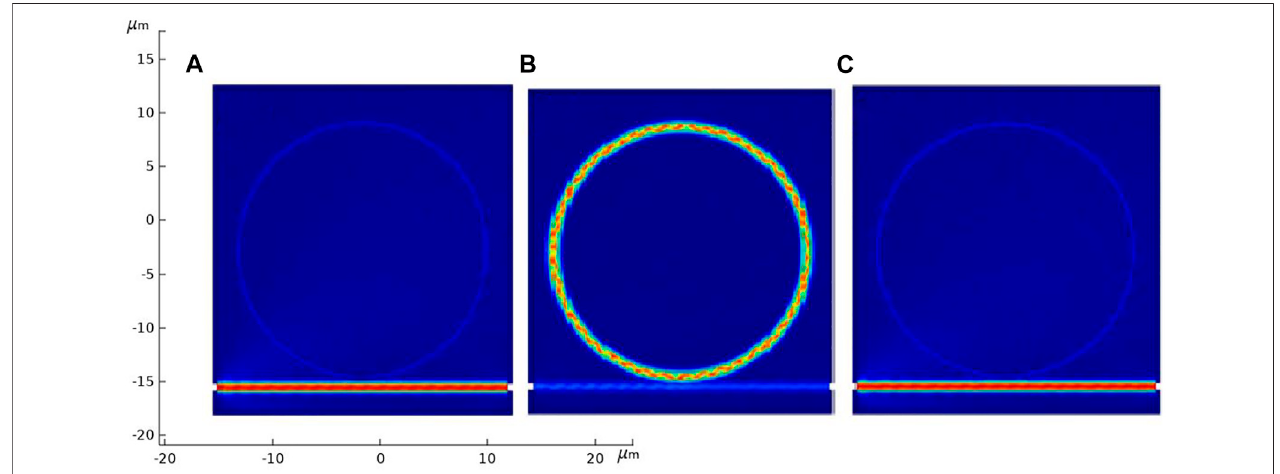
FIGURE 3 | Electric fi eld distribution when the temperature is fi xed at 30 ° C, and when the wavelength is (A) 1,542 nm, (B) 1,546 nm, or (C) 1,550 nm.